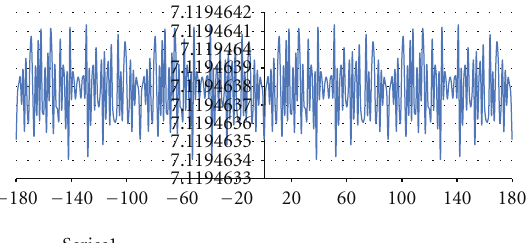
Figure 10: Gain plot at 6.1GHz (phi/degree versus